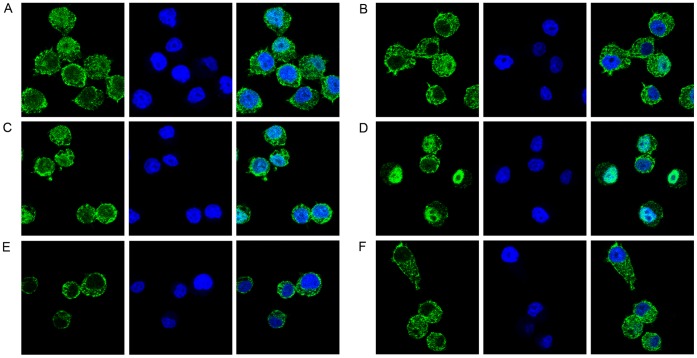
Cellular localization of NF-κB p65 in HeNC2 cells.HeNC2 cells were stimulated with Pam2CSK4 (100 ng/ml, panel A), Pam2CSK4 plus Hb (100 ng/ml and 50 µg/ml, respectively, panel B), LTA (1 µg/ml, panel C), LTA plus Hb (1 µg/ml and 50 µg/ml, respectively, panel D), Hb (50 µg/ml, panel E) or maintained in medium (panel F) for 4 hours. Cells were then fixed, permeabilized, blocked and incubated with NF-κB p65 overnight at 4°C. After washing, cells were incubated with anti-rabbit IgG conjugated to Alexa Fluor-488 (green). Cells were also stained with SYTOX Orange (blue) to visualize the nuclei and then analyzed by confocal microscopy.